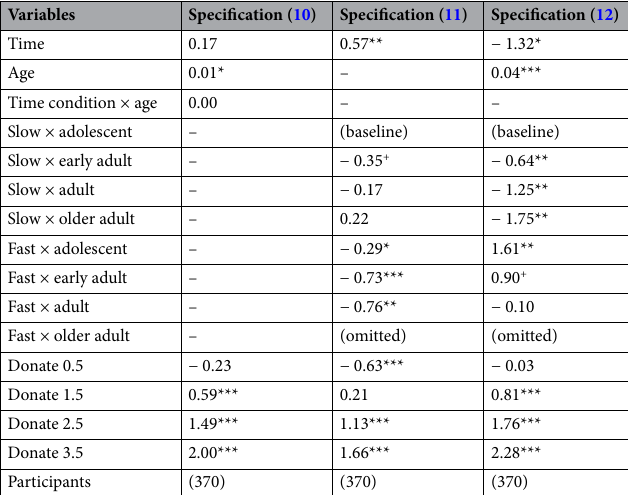
Table 9. Ordered probit estimates for specifications (10), (11), and (12). + p < 0.15 (marginally